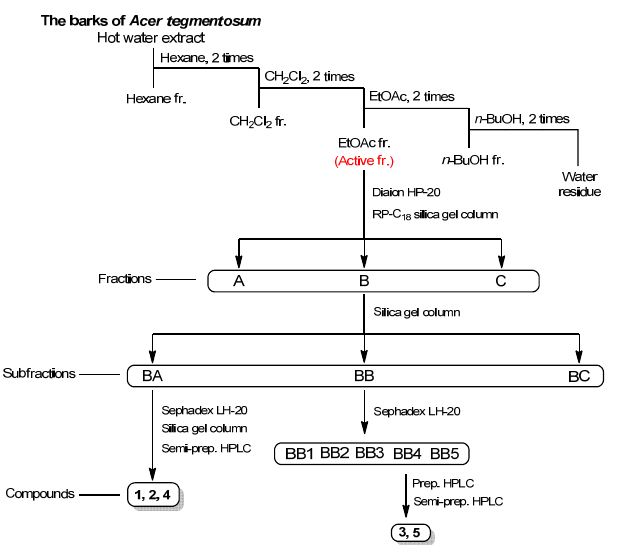
Figure 2. Isolation scheme of compounds 1 – 5 from the extract of Acer tegmentosum .